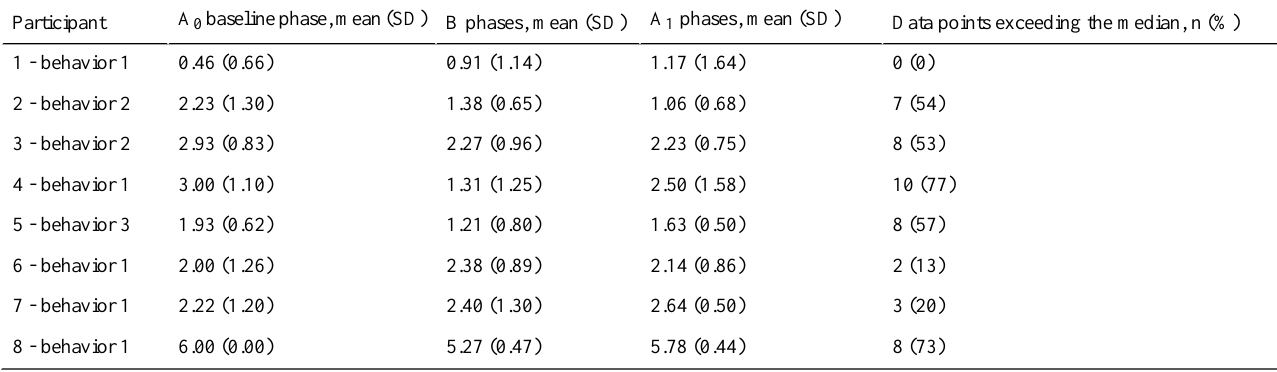
Table 5. Means and standard deviations of disruptive classroom behavior by phase and percentage of data points exceeding the median scores for each